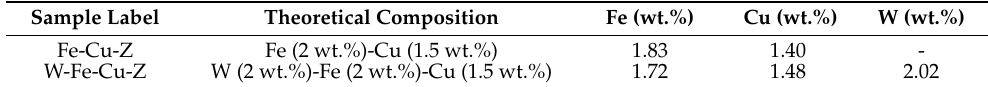
Table 1. ICP-OES chemical analysis